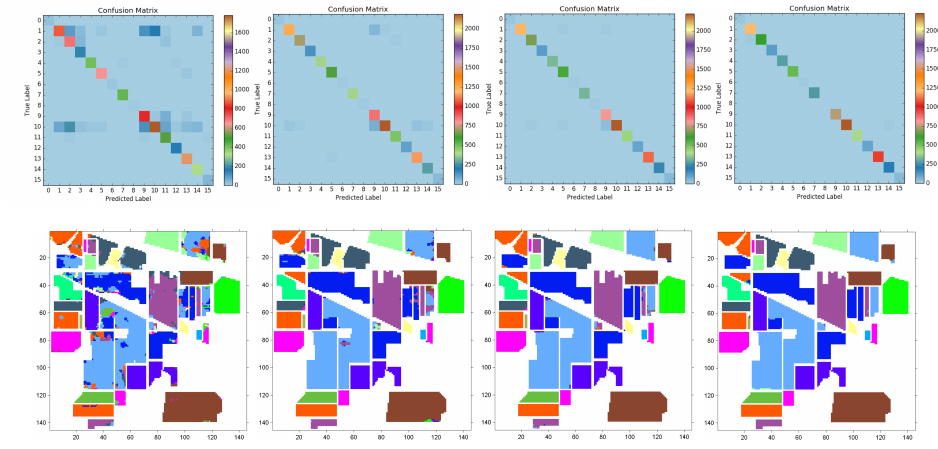
Figure 12. Classification results for the IP image with d = 15 and number of samples per category = 50 (first column), 100 (second column), 150 (third column), and 200 (fourth column). The upper row represents the visualization results of the confusion matrix for each category on the testing set (the more prominent the color of the diagonal area, the better the result) and the lower row represents the qualitative results of